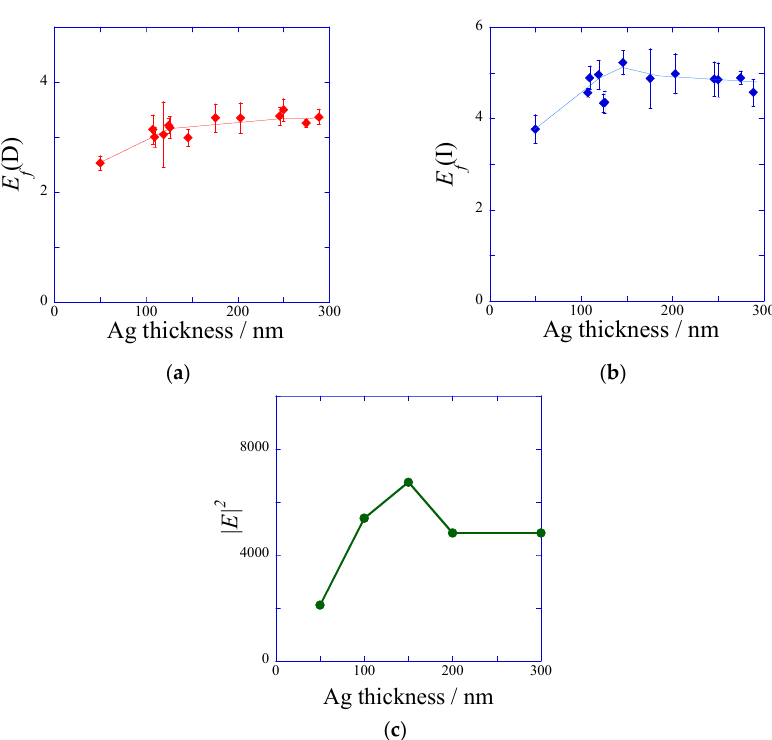
Figure 3. Enhancement factors against the silver film thickness in ( a ) DAS and ( b ) IAS measurement, which were evaluated as the fluorescence intensity at peak divided by the fluorescence intensity at baseline; and ( c ) the square of electric field intensity calculated against the silver film thickness by Finite-difference time-domain method (FDTD) method.